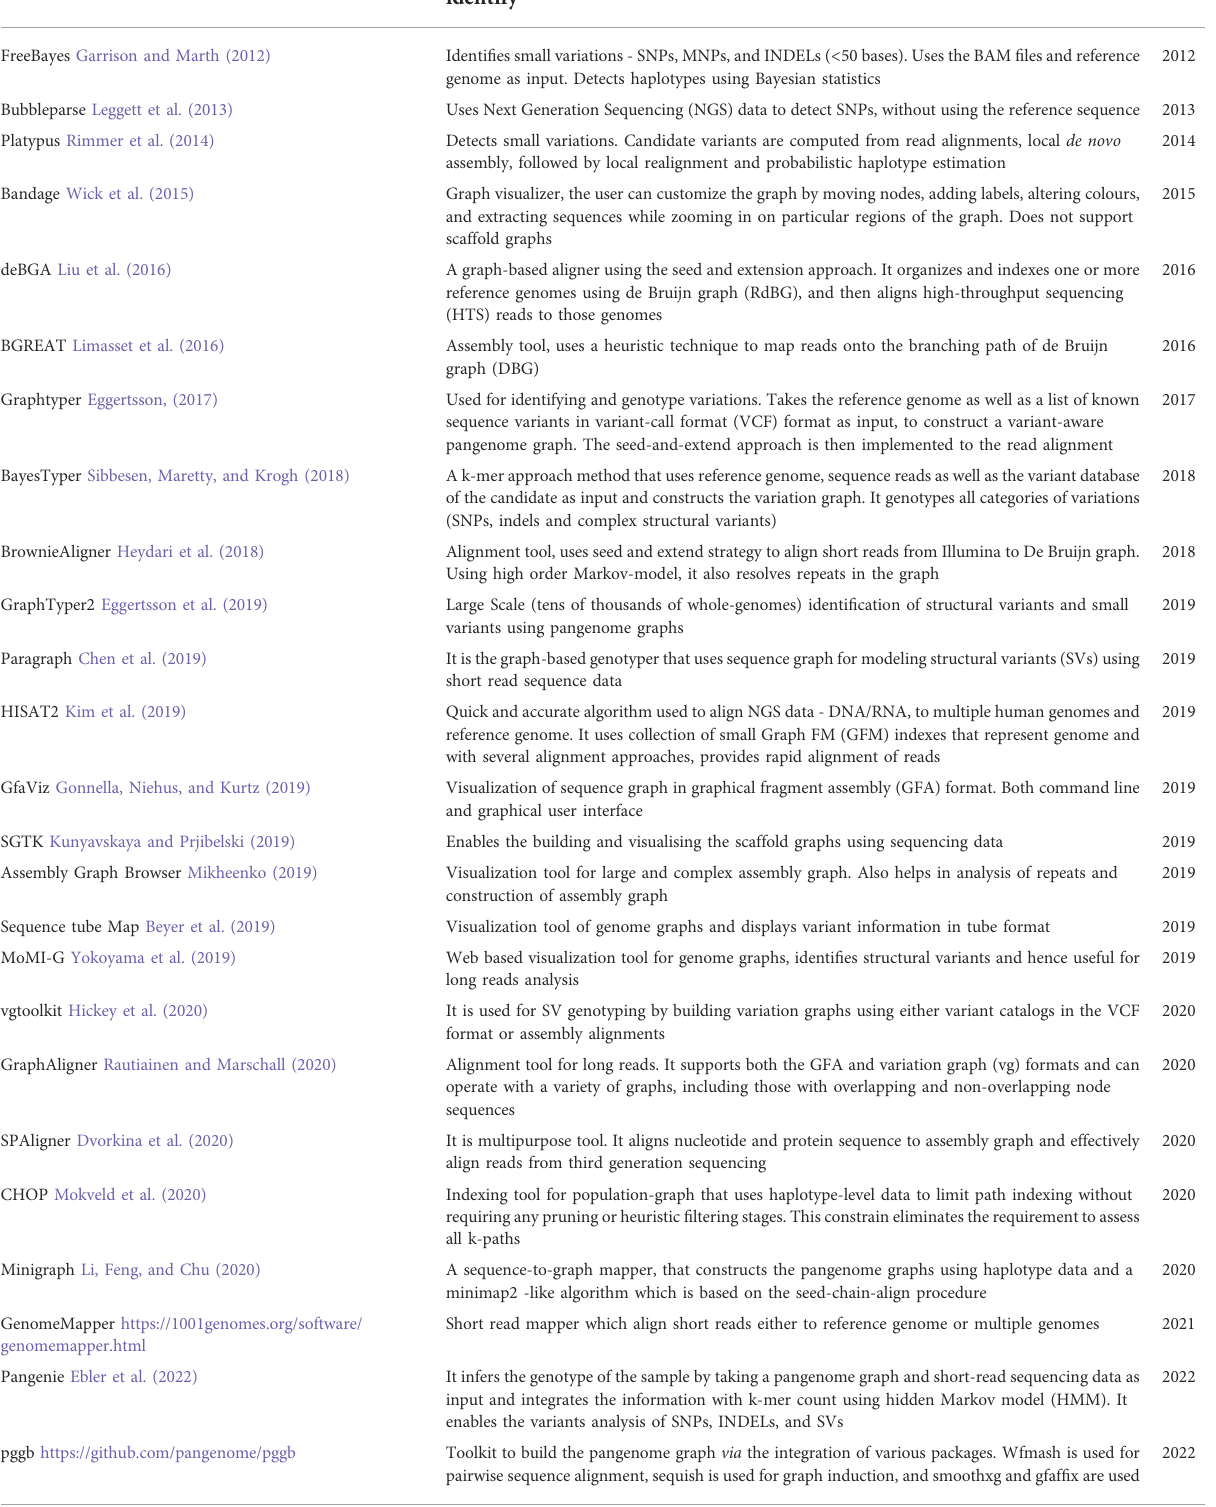
TABLE 1 List of pangenome applications and pipelines with brief description.